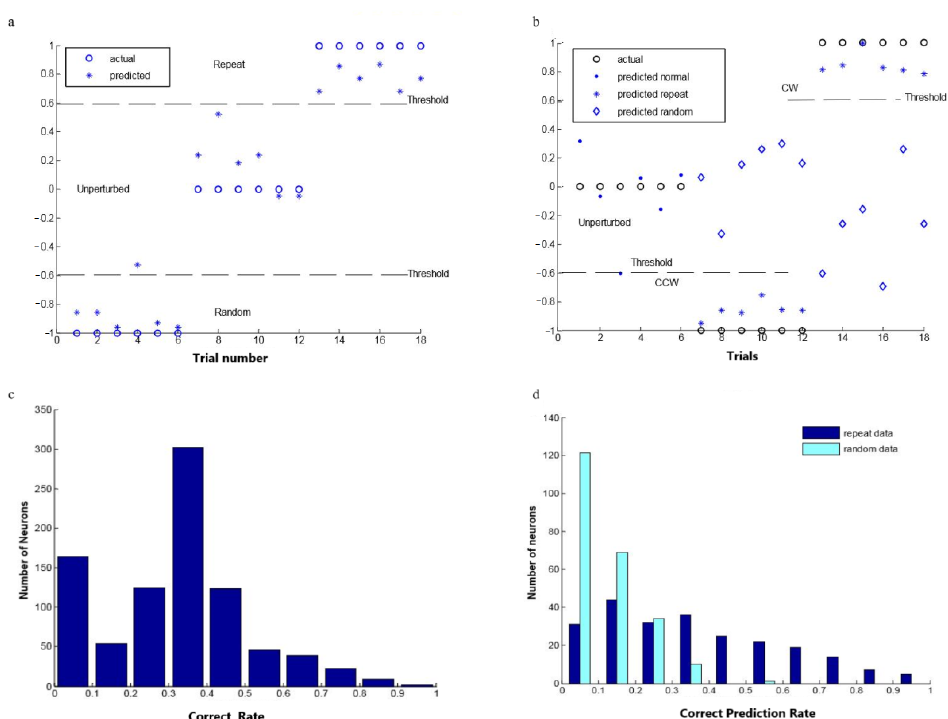
Figure 9. BP network predictions and correct rates. ( a ) Perturbation condition classification results for a typical motor cortical unit using the backpropagation neural network. The x -axis shows the trial number. There were 18 testing trials in total (Trial 1~6: actually from random perturbation; Trial 7~12: actually from 90 ◦ unperturbed; Trial 13~18: actually from repeat perturbation). ( b ) Repeat perturbation prediction results from a typical motor cortical unit using the backpropagation neural network. The x -axis shows the trial number. There were 18 testing trials in total (Trial 1~6: actually from 90 ◦ unperturbed; Trial 7~12: actually from repeat 45 ◦ CCW; Trial 13~18: actually from repeat 45 ◦ CW). ( c ) Distribution of single-unit perturbation condition classification performance. This figure includes 885 task-related neurons recorded during the perturbation experiments. ( d ) Comparison of the perturbation prediction performance between the random data and the repeat data input. This figure only includes neurons that showed significant anticipatory activity ( n =